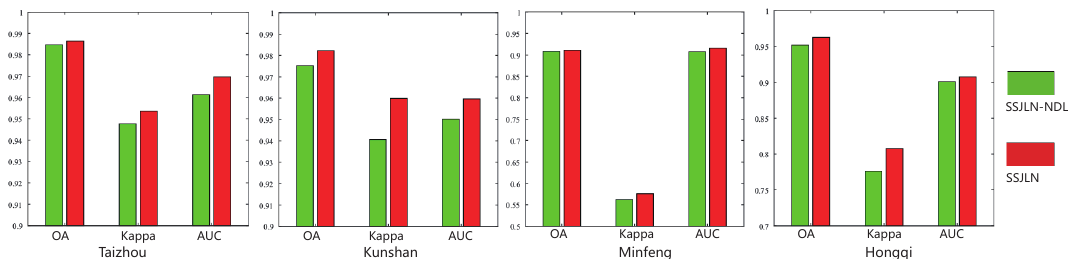
Figure 6. OA, Kappa and AUC values comparision of four different data sets. Green color denotes SSJLN-NDL method that does not contain the discrimination learning part and red color denotes